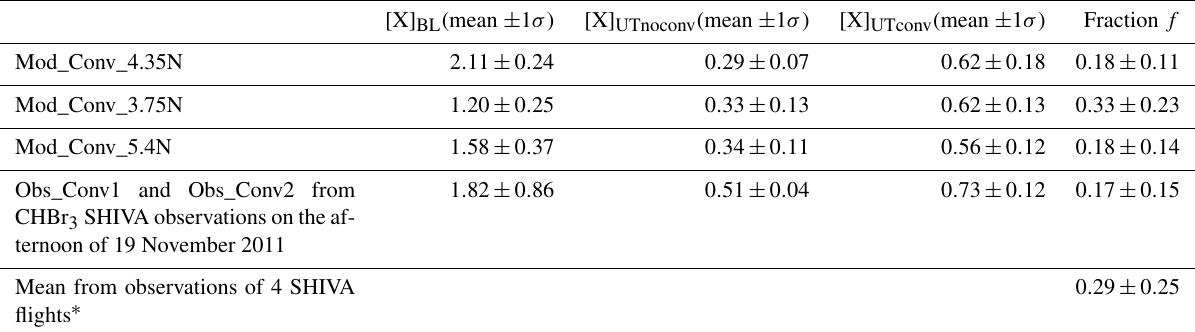
Table 3. Estimates from the model simulations of the CHBr 3 mixing ratios (all in pptv) in the boundary layer [X] BL , in the UT outside convection [X] UTnoconv , and in the UT within convection [X] UTconv . f is the air fraction originating from the boundary layer and transported by convection. Details on the method used are given in Supplement S2. The error listed for f is calculated by propagating the standard deviation errors on each [X] term used to calculate it. The equations to explain the propagation of error are given in Supplement S3.